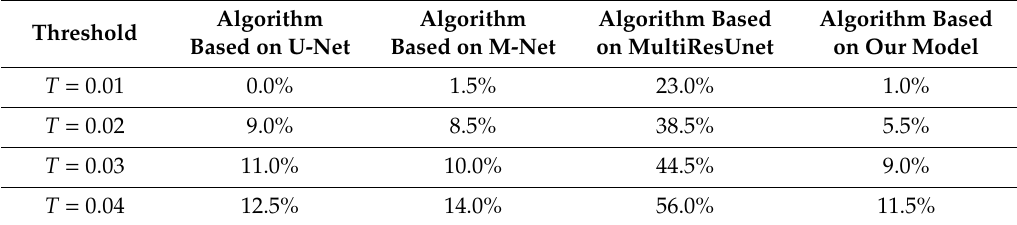
Table 10. Omission factor of sensitivity to tampering with appending